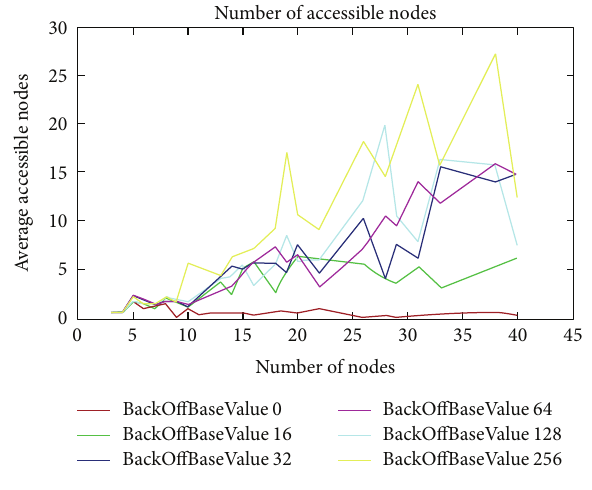
Figure 12: BackOffType =